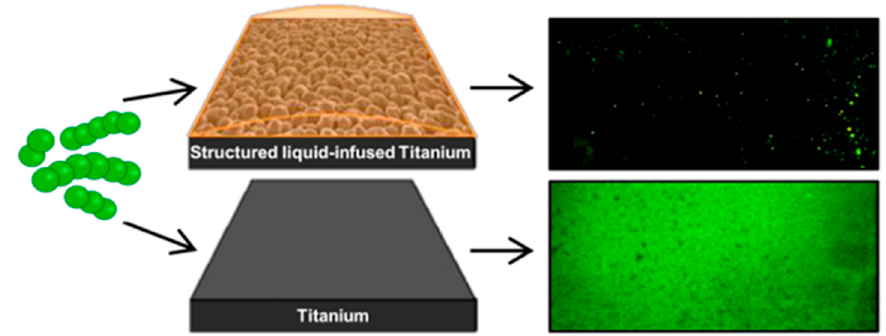
Figure 13. Strong biofilm-repellent properties of SLIPS on titanium structured by ultrafast laser processing. (Reprinted (adapted) with permission from [90]. Copyright 2017 American Chemical Society.)